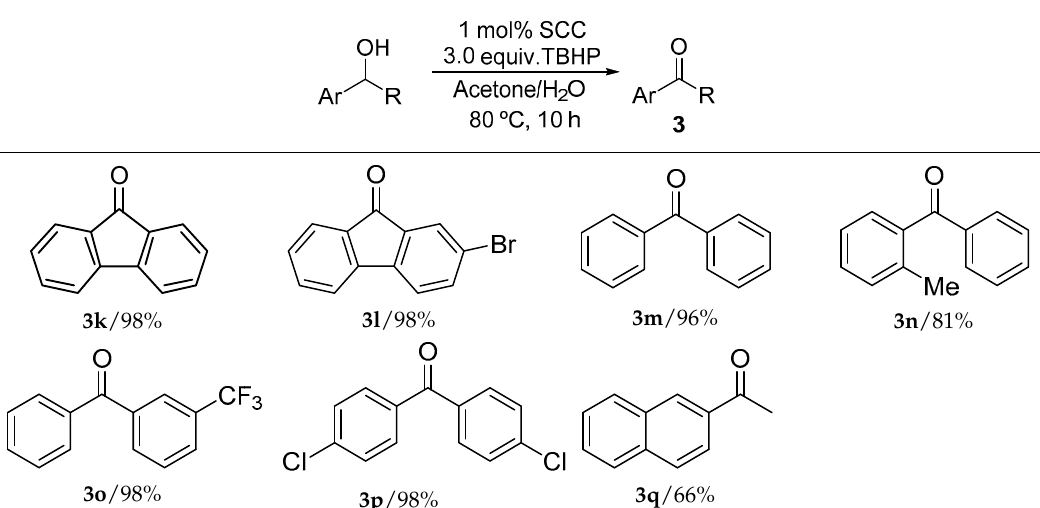
Table 3. The oxidation of benzyl alcohol catalyzed by SCC a .